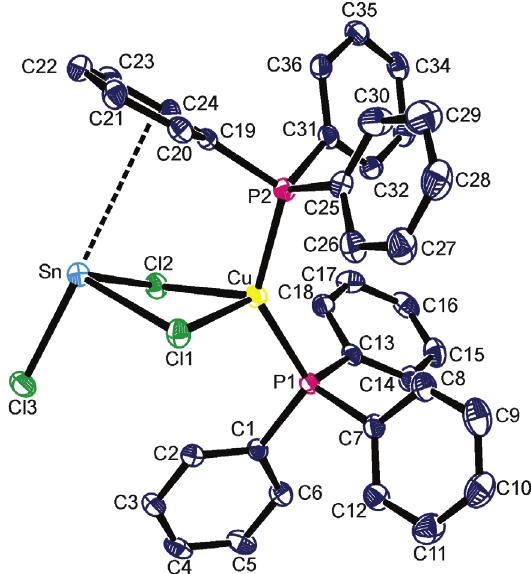
Figure 4 The asymmetric unit of 4 showing the labeling scheme used. toluene molecule has been omitted for clarity, as have the hydro-